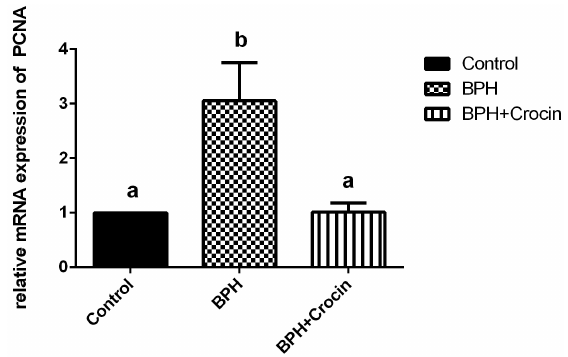
Fig. 4. PCNA mRNA expression in the experimental rats showing the effect of crocin treatment. Data represent the mean ± SEM. Means with different superscript letters are significantly different from one another ( P < 0.05). Abbreviations: BPH, be- nign prostatic hyperplasia; PCNA, proliferating cell nuclear anti- gen.